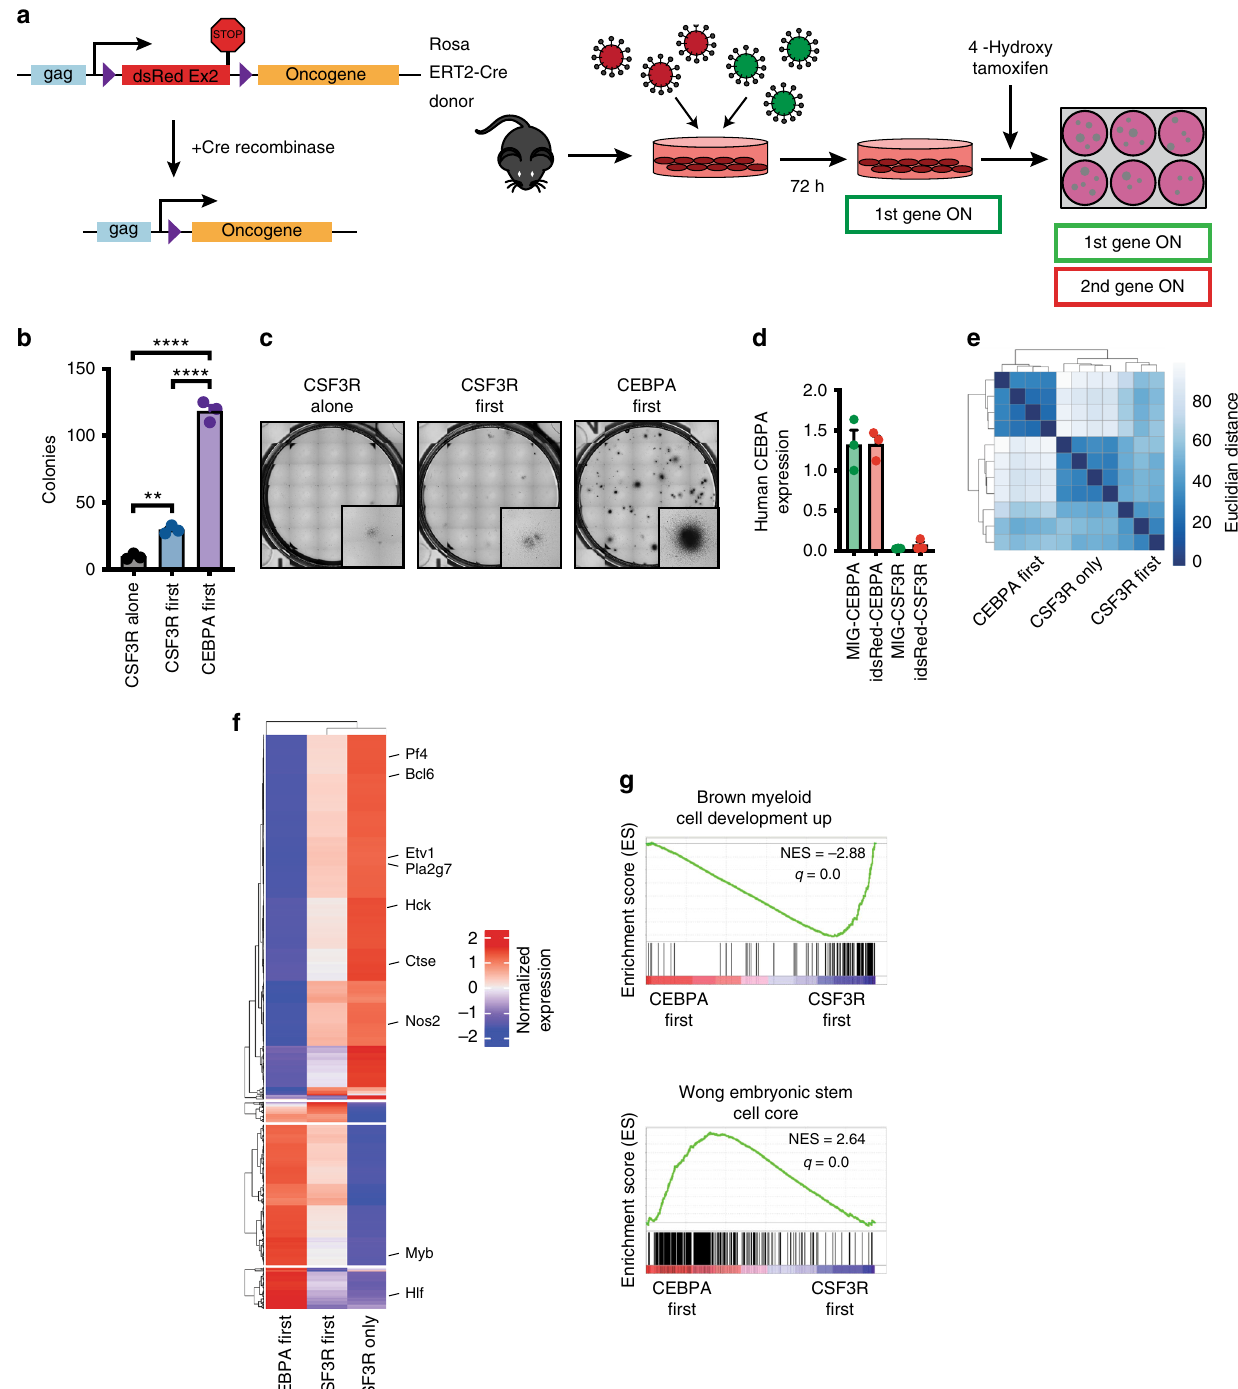
Fig. 6 CEBPA mutations must precede mutations in CSF3R to block differentiation. a Diagram of order of acquisition system. Oncogenes in the MIG (GFP + ) vector tagged with GFP are constitutively expressed, and oncogenes in the idsRed vector are expressed only after Cre-mediated recombination. Expression of the second oncogene can be induced by culture in 4-OHT. b Colony assay from mouse bone marrow transduced with CEBPA First (MIG-CEBPA V314VW + idsRed-CSF3R T618I ) CSF3R First (MIG-CSF3R T618I + idsRed-CEBPA V314VW ) and CSF3R only (MIG-CSF3R T618I + idsRed Empty) and plated in 4-OHT ( n = 3/ group). c Representative images of colony assay. d Human CEBPA and CSF3R expression in mouse bone marrow expressing MIG-CEBPA V314VW , idsRed- CEBPA V314VW , MIG-CSF3R T618I or idsRed-CSF3R T618I measured by TaqMan quantitative PCR ( n = 3/group). e Clustering by Euclidian distance for RNA sequencing performed on lineage negative mouse bone marrow expressing CEBPA- fi rst, CSF3R- fi rst, or CSF3R-only ( n = 3 – 4/group). f K-means clustering of top 750 differentially expressed genes per pairwise comparison ( q <0.05, log 2 Fold Change< − 1 or >1) ( n = 3 – 4/group). g Representative enriched gene sets from GSEA performed on samples from e ( n = 3 – 4/group). GSEA p value calculated by empirical permutation test and FDR adjusted. In all cases, values are represented as mean with error bars representing SEM. ** p <0.01, **** p < 0.0001, as measured by ANOVA with Sidak ’ s post-test. Source data are provided as a Source Data fi